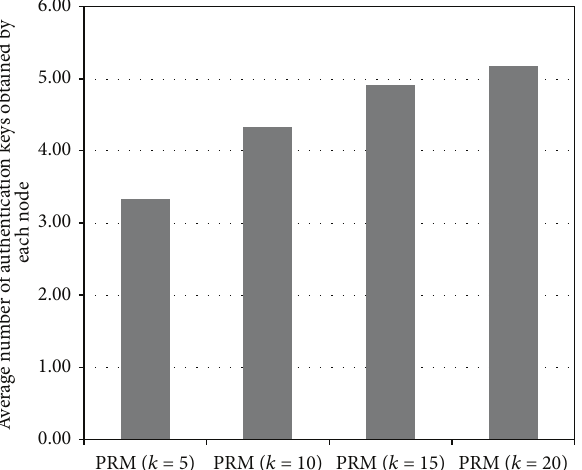
Figure 12: The number of authentication keys obtained by each node for different 𝑘 values (𝛼 𝑃 = 0.2) .